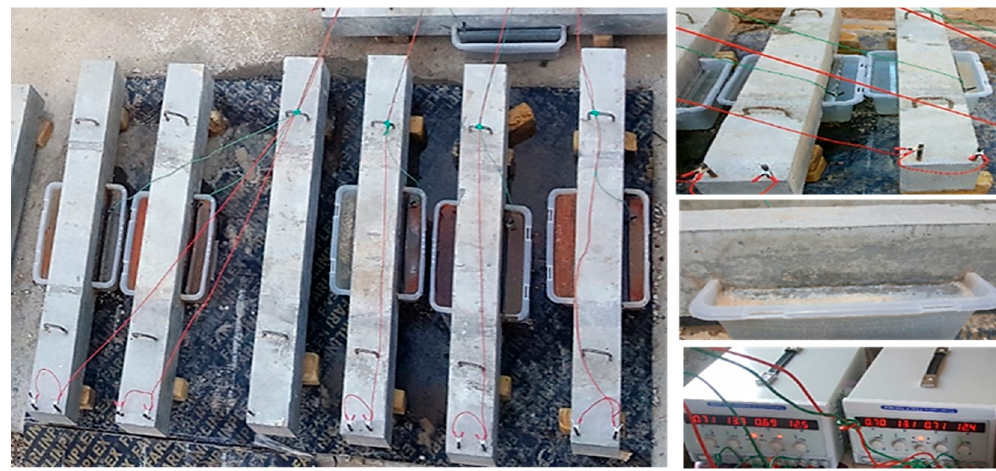
Figure 2. Acceleration corrosion process.